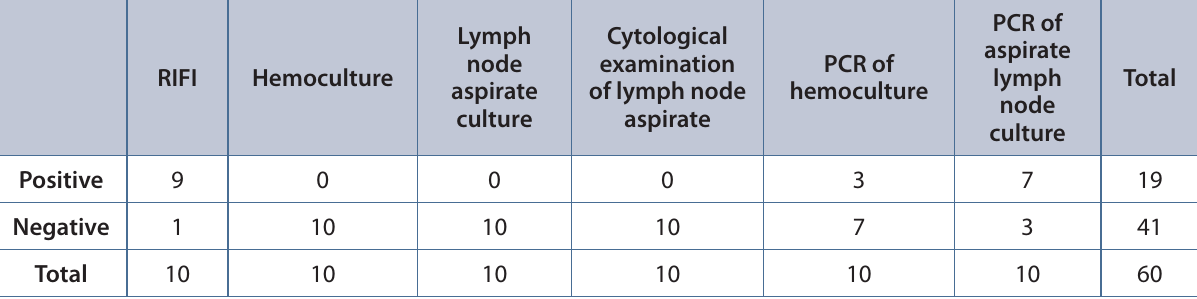
RIFI vs. hemoculture = aspirate lymph node culture = cytological examination of lymph node aspirate: p = 0.32 RIFI vs. PCR of hemoculture: p = 0.32 RIFI vs. PCR of lymph node aspirate culture: p = 0.03 PCR of hemoculture vs. PCR of lymph node aspirate culture: p = 1.00 McNemar’s test was utilized in